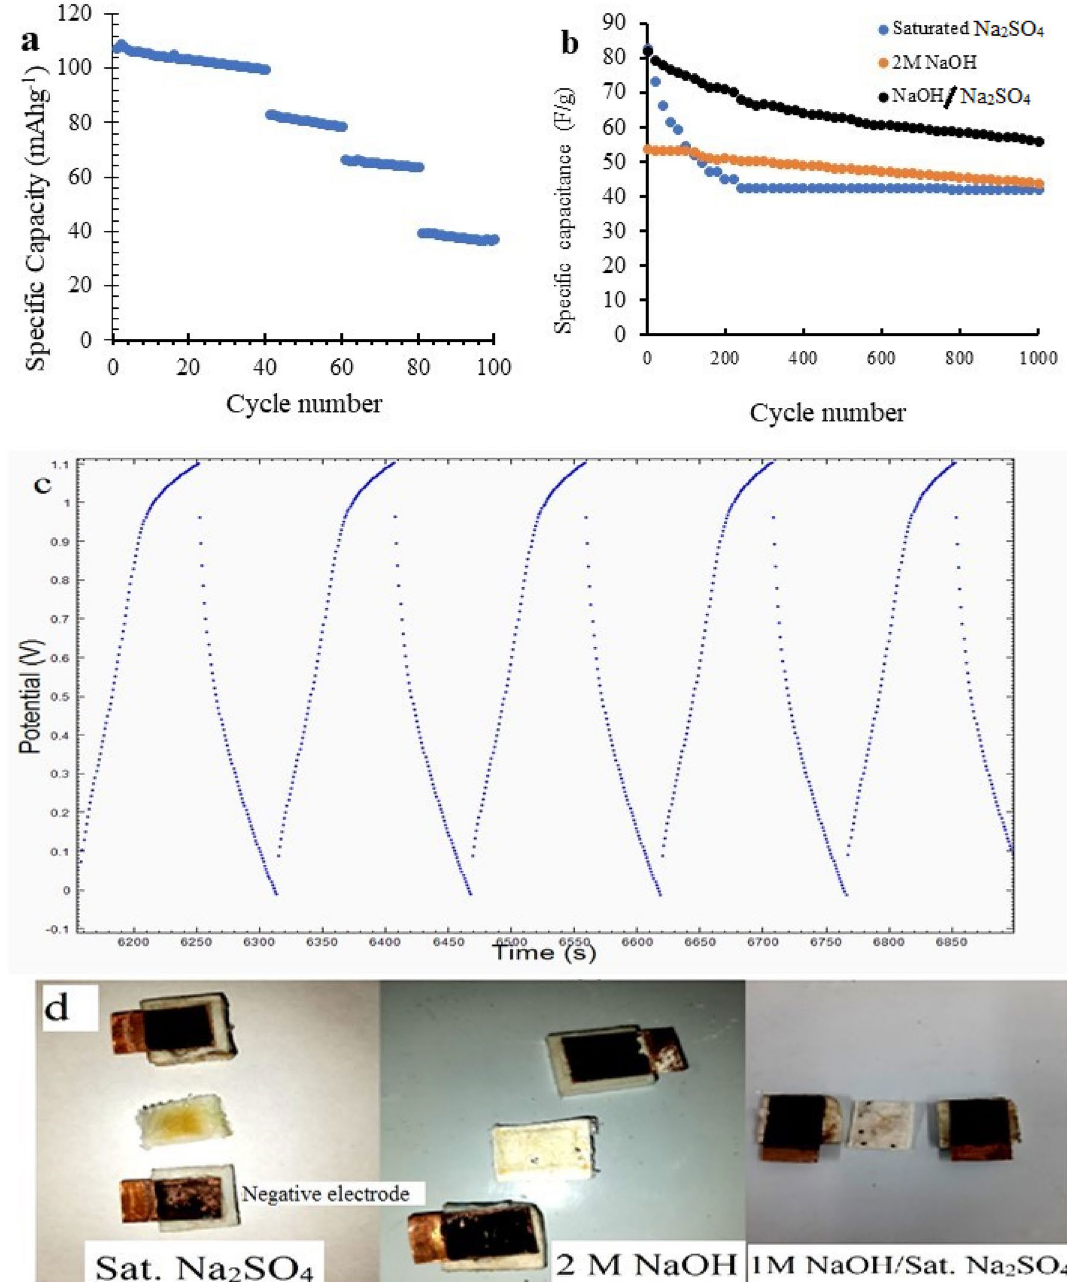
Figure 7. ( a ) Cyclic performance of Fe(60) sample in Na-ion cell at different C rates. ( b ) Cyclic performance of Fe(60) sample as symmetric electrochemical capacitor in different electrolytes, ( c ) cycles 50–55 of Fe(60) sample cycling test with saturated Na 2 SO 4 and ( d ) electrodes after 1000 cycles using different